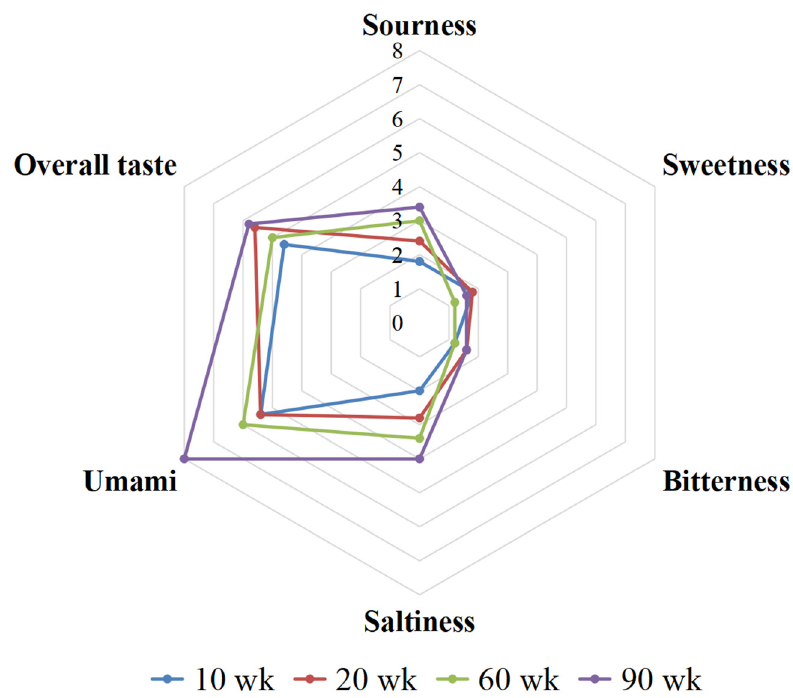
Figure 1. Taste profiles of four chicken soup samples.